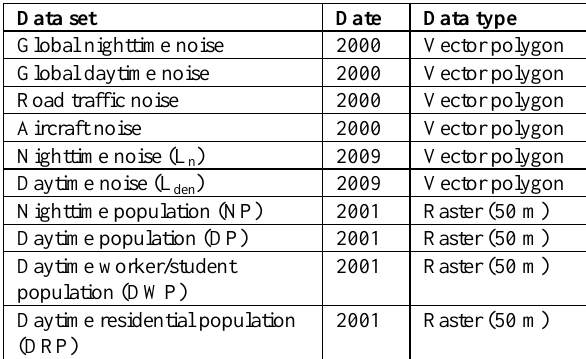
Table 1. Main input data sets used